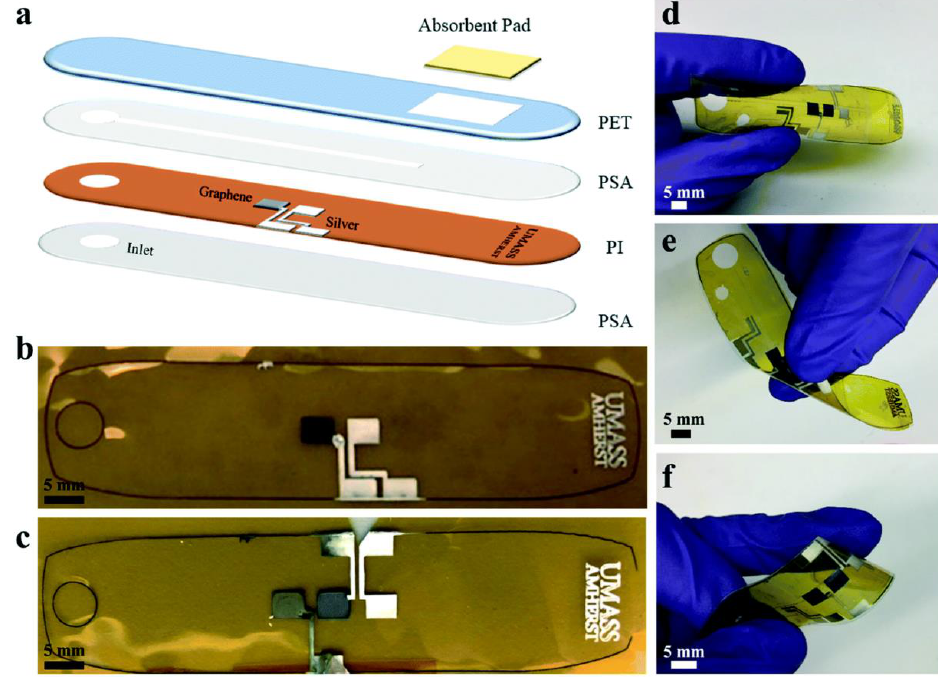
Figure 7. Fabrication of a cortisol detection and glucose-monitoring biosensor. ( a ) Illustration of laser-cut microfluidic device fabrication and assembly of the electrode and connector layout. Pressure-sensitive adhesive microchannel cutout (1 mm wide) was used between polyimide (PI) and hydrophilic polyethylene terephthalate (PET) (with a SiO 2 -based hydrophilic coating) substrates. The absorbent pad was used for constant evaporation of sweat through the device. ( b ) Inkjet-printed glucose sensor with silver (right) and graphene (left) electrodes. Graphene and silver inks were printed for high-temperature stability. ( c ) Inkjet-printed chronoamperometric cortisol sensor with silver (right), graphene (middle), and graphene/Au NP ( left ) electrodes. ( d – f ) Bending and twisting mechanical deformation demonstration of the assembled cortisol sensor. Reprinted with permission from [189].